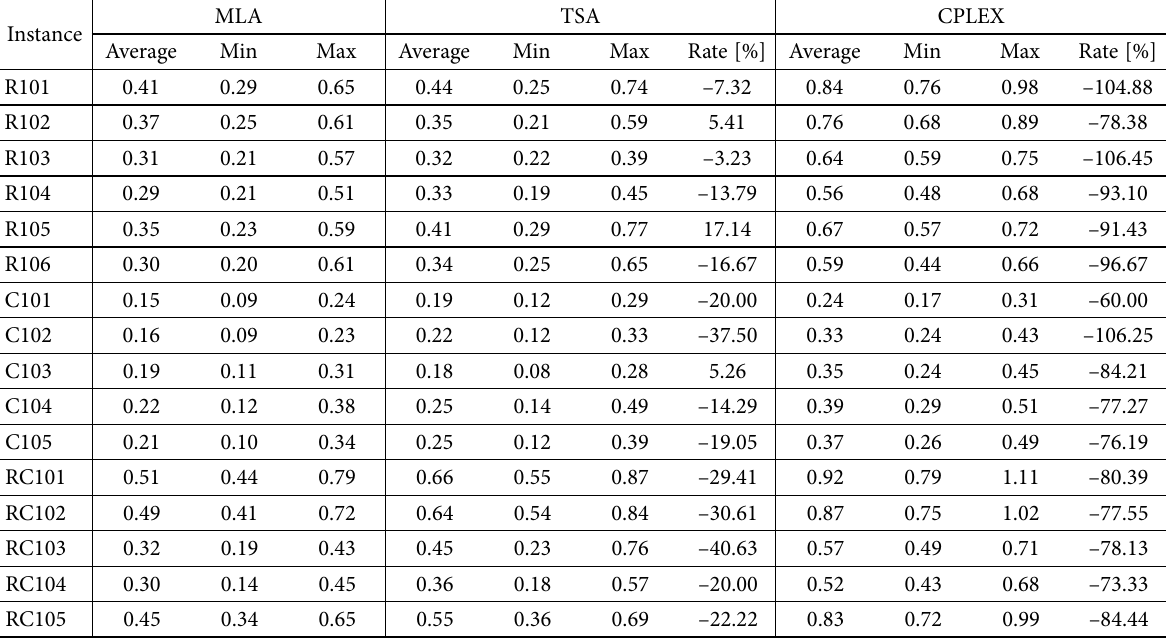
Table 5. Comparison results of different methods for path searching in VRPTW (runtime